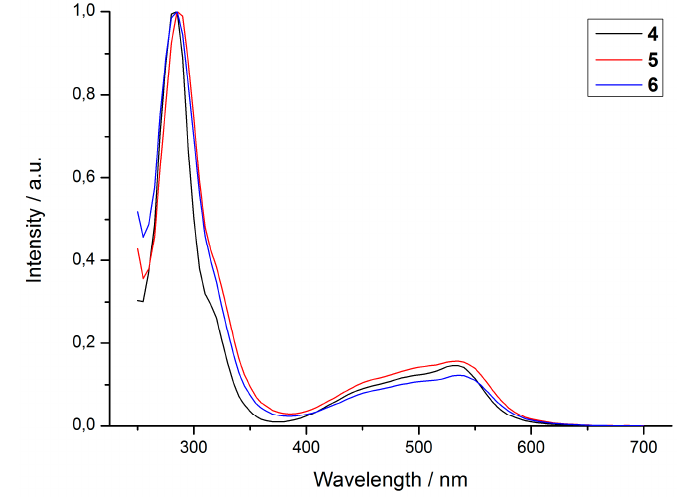
Figure 3. Normalized UV/Vis spectra of the complexes 4 – 6 in CH 3 CN.